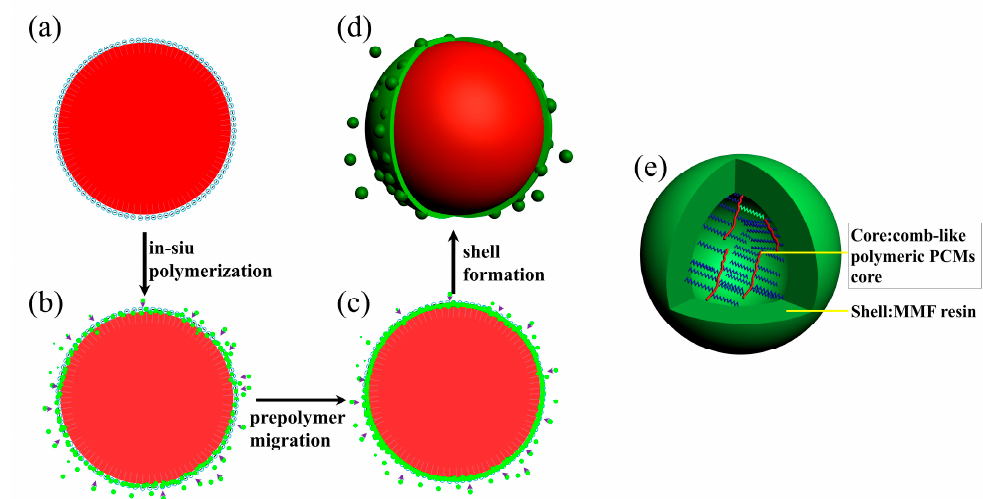
Figure 1. Schematic diagram of encapsulation process via in-situ polymerization: ( a ) oil core droplets, ( b ) microencapsulation process, ( c ) crosslinking process, ( d ) microcapsule; and ( e ) schematic structure of Micro/NanoPCMs containing comb-like polymeric phase change materials.